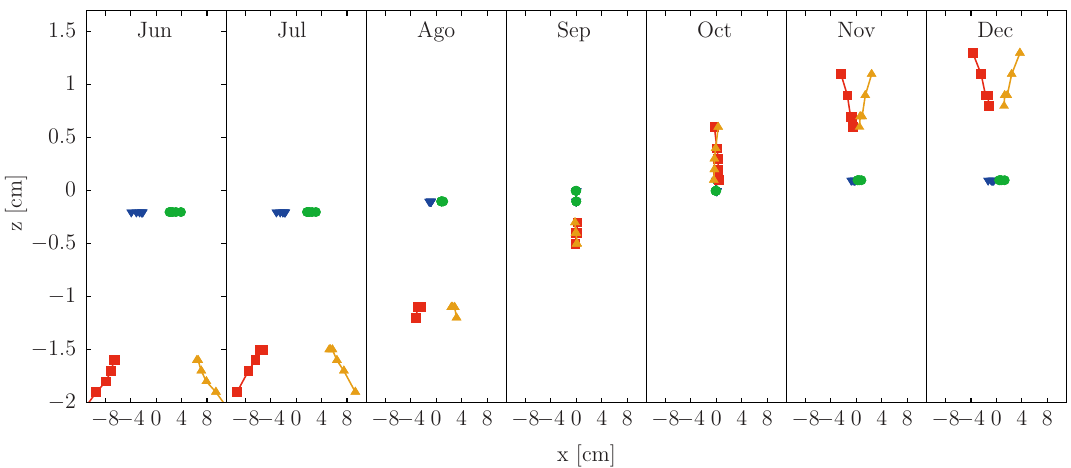
Figure 5. Central rays’ impact points of each facet on the target for an H4 array, and for the 21st day of each month from June to December. The array is located at 0.75 h (26.25 m).